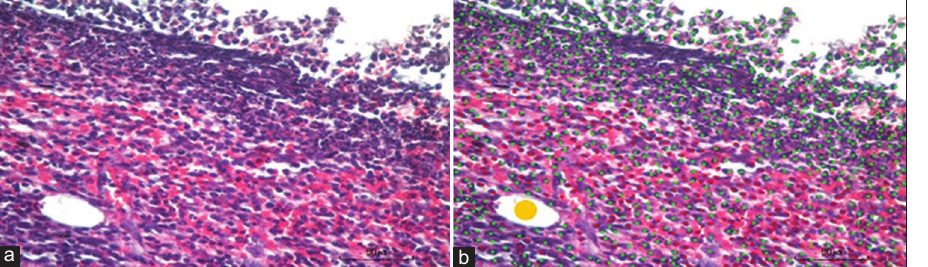
Figure-4: Wound histology on day 21 (hematoxylin and eosin staining, 400×); (a) original photo; (b) the counting, green dots show neutrophil, yellow dots show neovascularization, and red dots show mononuclear cell.